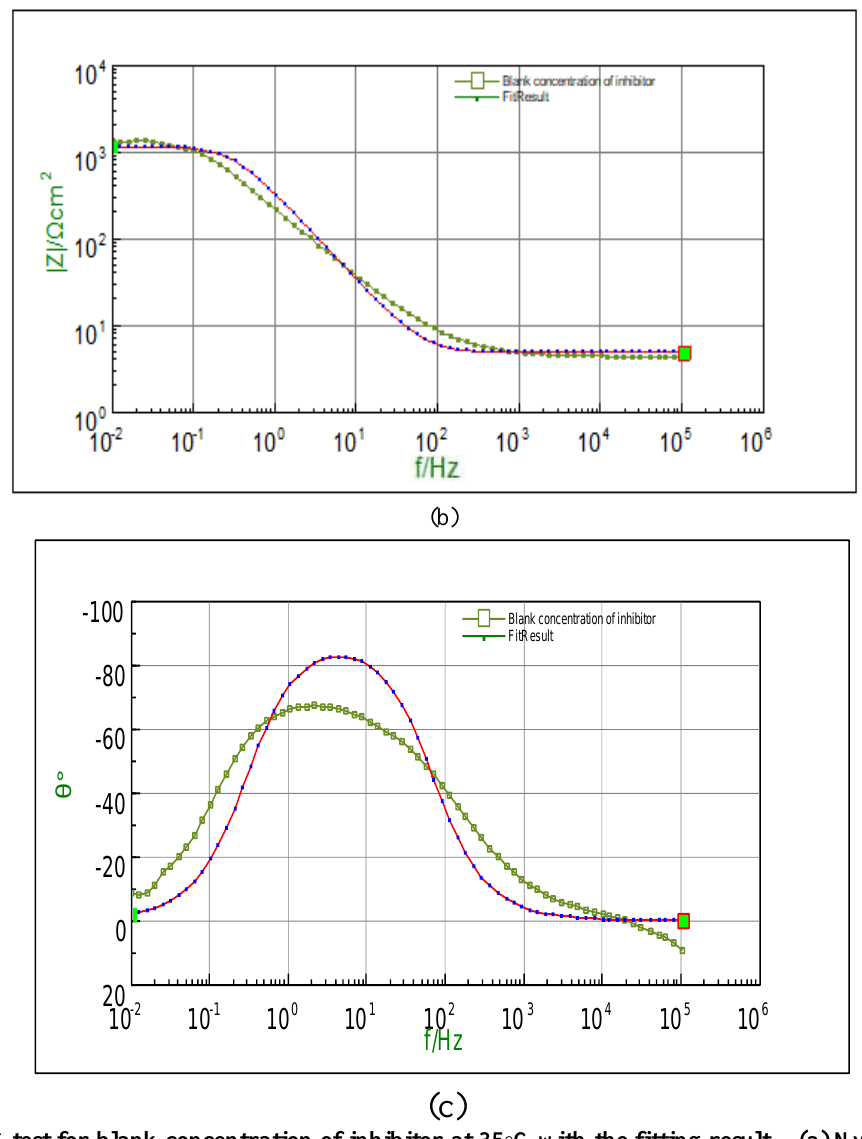
Fig. 8. The EIS test for blank concentration of inhibitor at 35◦C with the fitting result. . (a) Nyquist plot, (b, c) Bod (log versus |z|), and phase angle (log f versus ∝ 𝟎 )